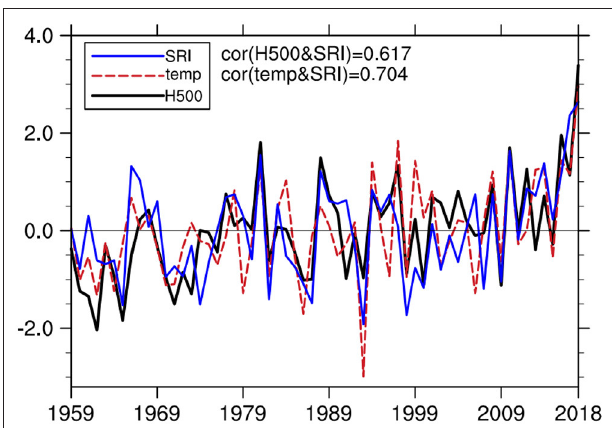
FIGURE 9 | Interannual series of the regional mean (high-temperature region 110–130 ◦ E, 35–47.5 ◦ N) normalized 2m temperatures, 500 hPa geopotential heights and